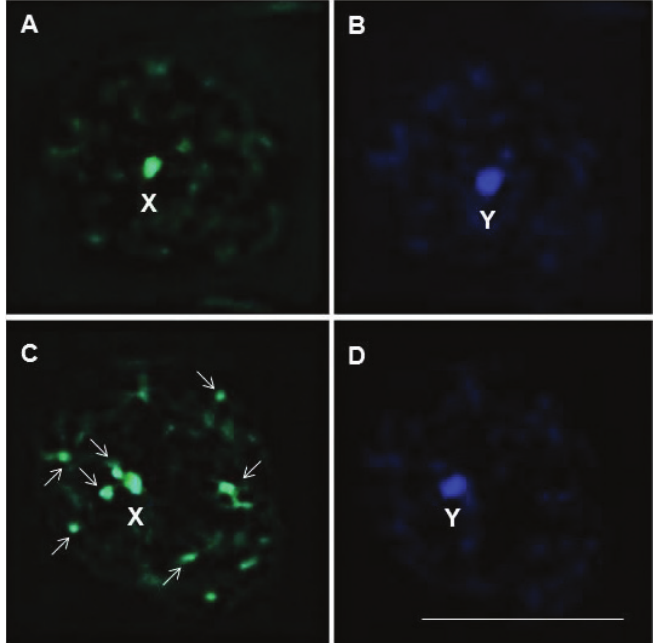
Figure 12. Composition of the pairs of bases of DNA rich in AT and CG in R. neglectus ( A, B ) and R. taquarussuensis ( C, D ). A X sex chromosome rich in CG B Y sex chromosome rich in AT C X sex chro- mosome and various blocks dispersed in the prophase nucleus (arrows) rich in CG D Y sex chromosome rich in AT. X: X sex chromosome, Y: Y sex chromosome. Bar: